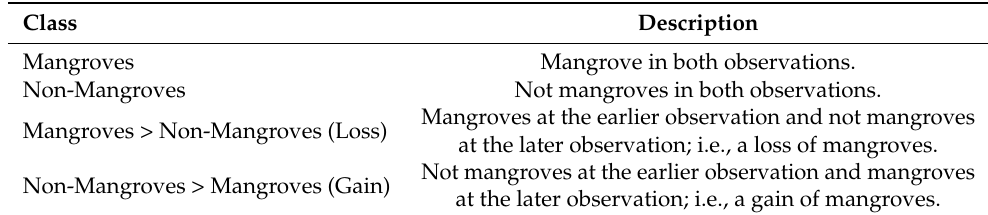
Table 4. Definitions of the change